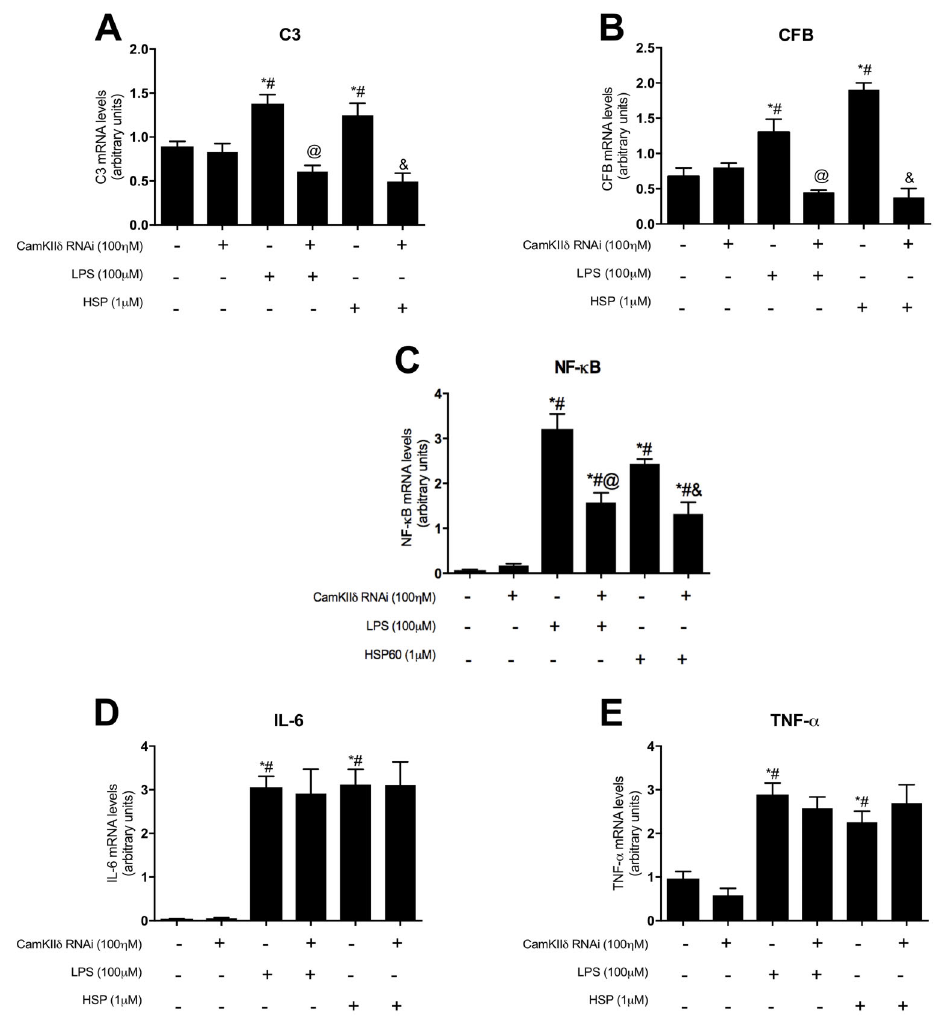
Figure 4. Effects of the silent CaMKII d in the complement system components. A , Analysis of C3 gene, B , CFB gene, C , NF- k B, D , IL-6, and E , TNF- a gene expressions evaluated by real time PCR, in cardiomyocytes treated with 0.1 m M of the interference RNA for 48 h, followed by 100 m M of LPS or 1 m M of HSP60 for 24 h, and control cells. Data are reported as means ± SE. *P o 0.05 vs Control, # P o 0.05 vs RNAi control; @ P o 0.05 vs LPS treatment; & P o 0.05 vs HSP60 treatment